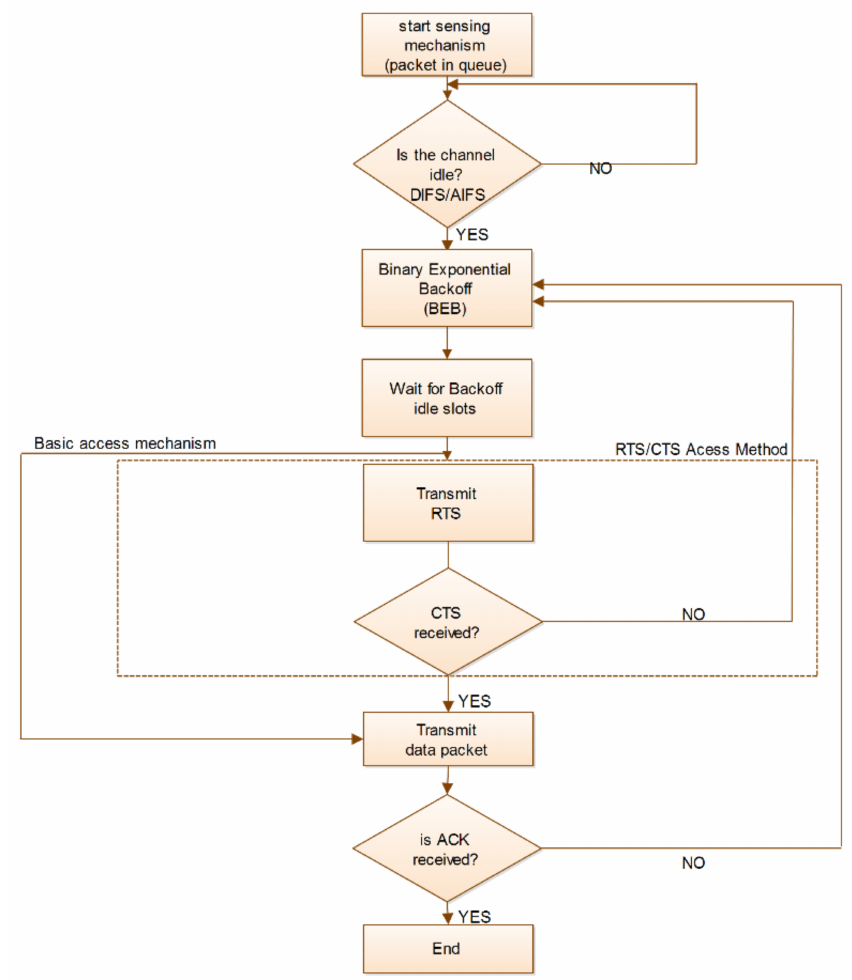
Figure 3. The flow chart of contention‑based